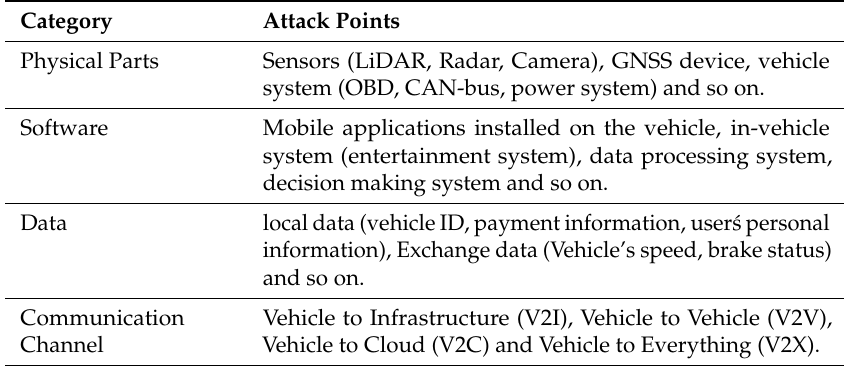
Table 2. Possible attack